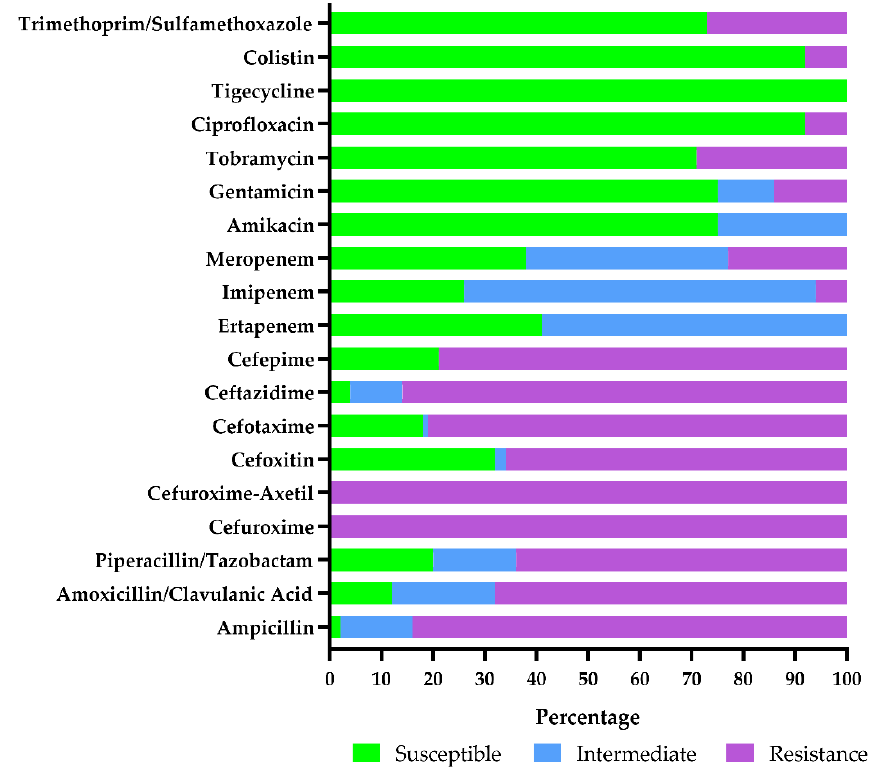
Figure 3. Antibiotic resistance patterns of E. coli isolates ( n = 100) using the VITEK ® 2 automated system (bioMérieux, Marcy-l ’ Étoile, France) in Johannesburg, South Africa.